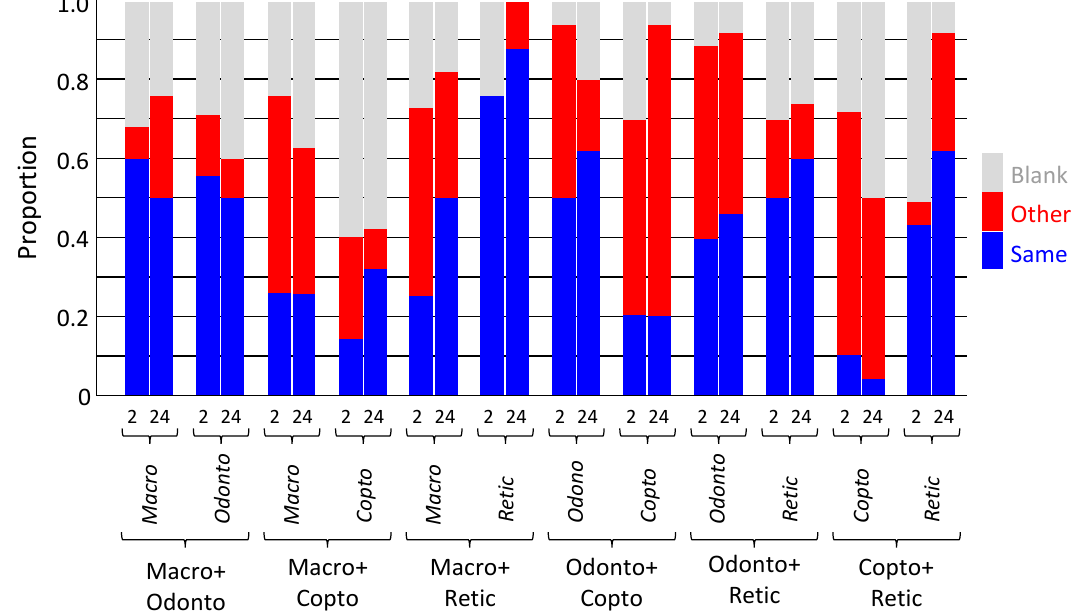
Figure 6. Location of termites in chemical detection experiment. Termites were offered three pieces of rolled filter paper: from the same species (another colony), other species, or blank. Locations recorded after 2 and 24 hours. Macro = Macrotermes barneyi ; Odonto = Odontotermes formosanus ; Copto = Coptotermes formosanus ; Retic = Reticulitermes flaviceps .